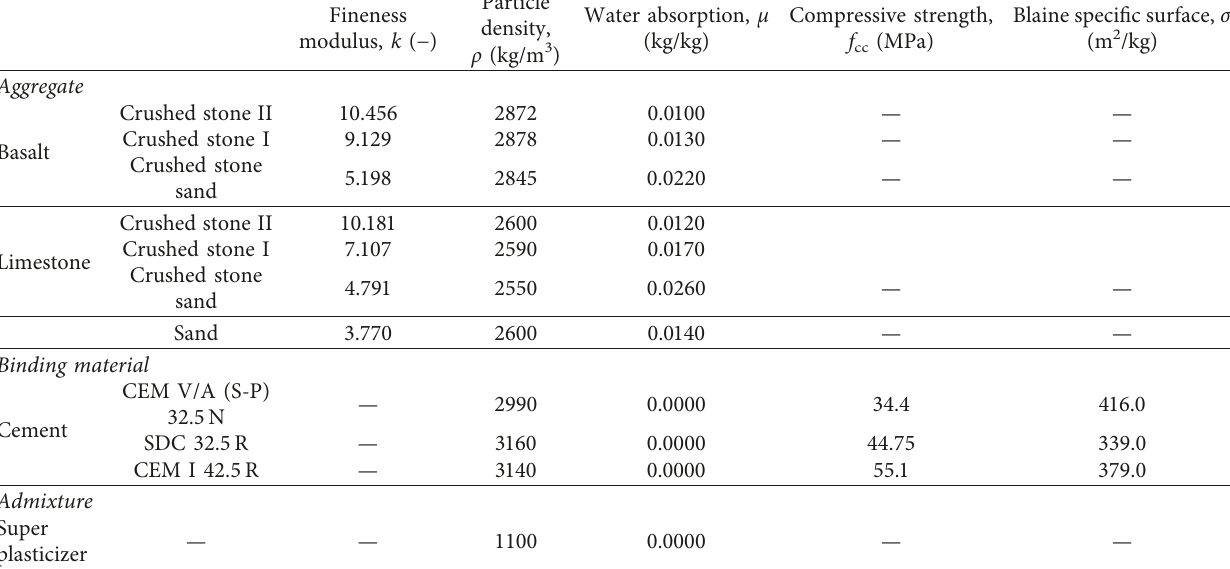
Table 1: Properties of the constituents.